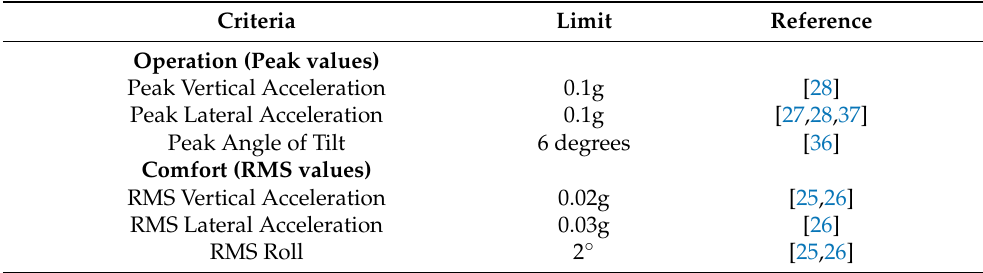
Table 1. Safe Motion Limits (SML) adopted for this study as relevant for older children and adults (ages 7–65